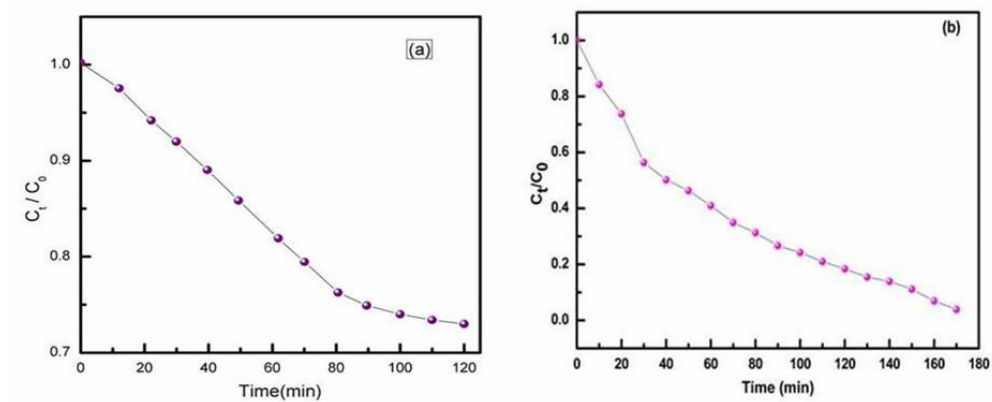
/C with time in presence of (a) PPY (b) t 0